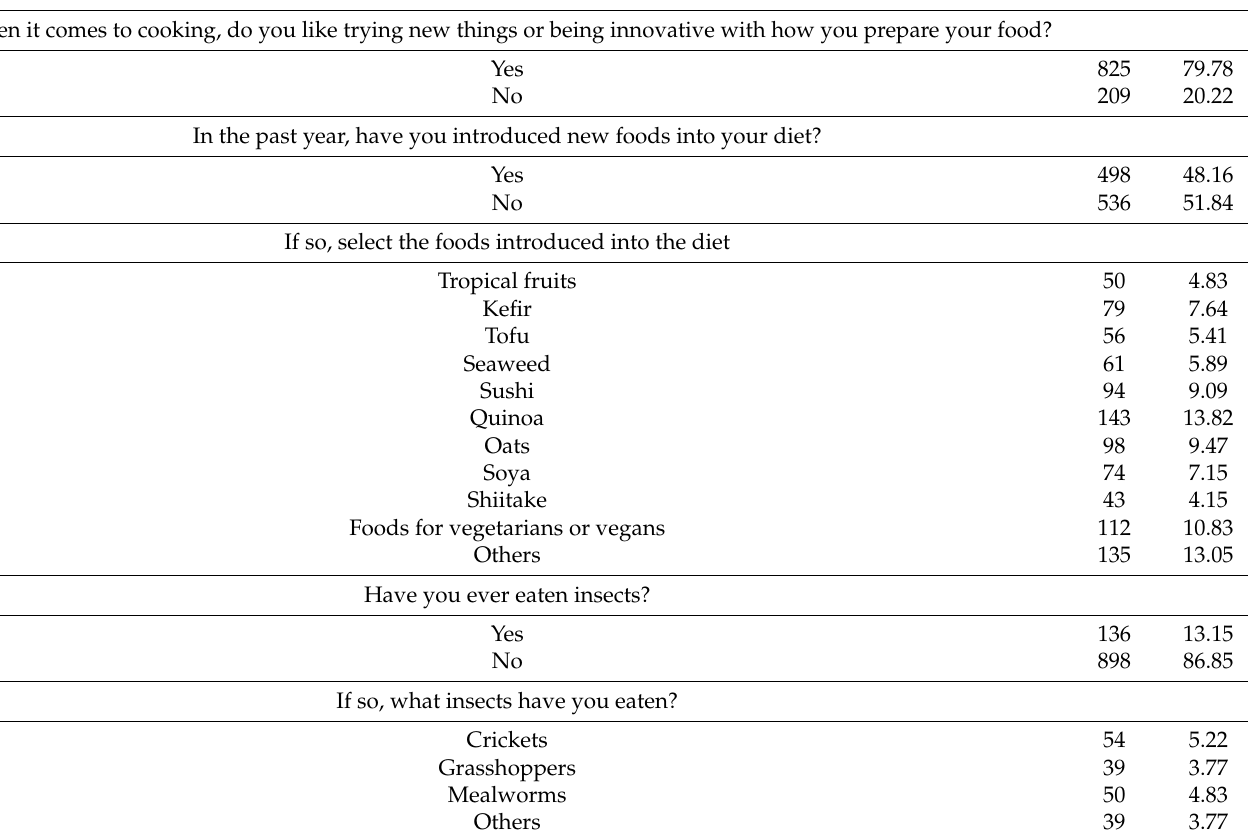
Table 2. Distribution of participants’ responses to the